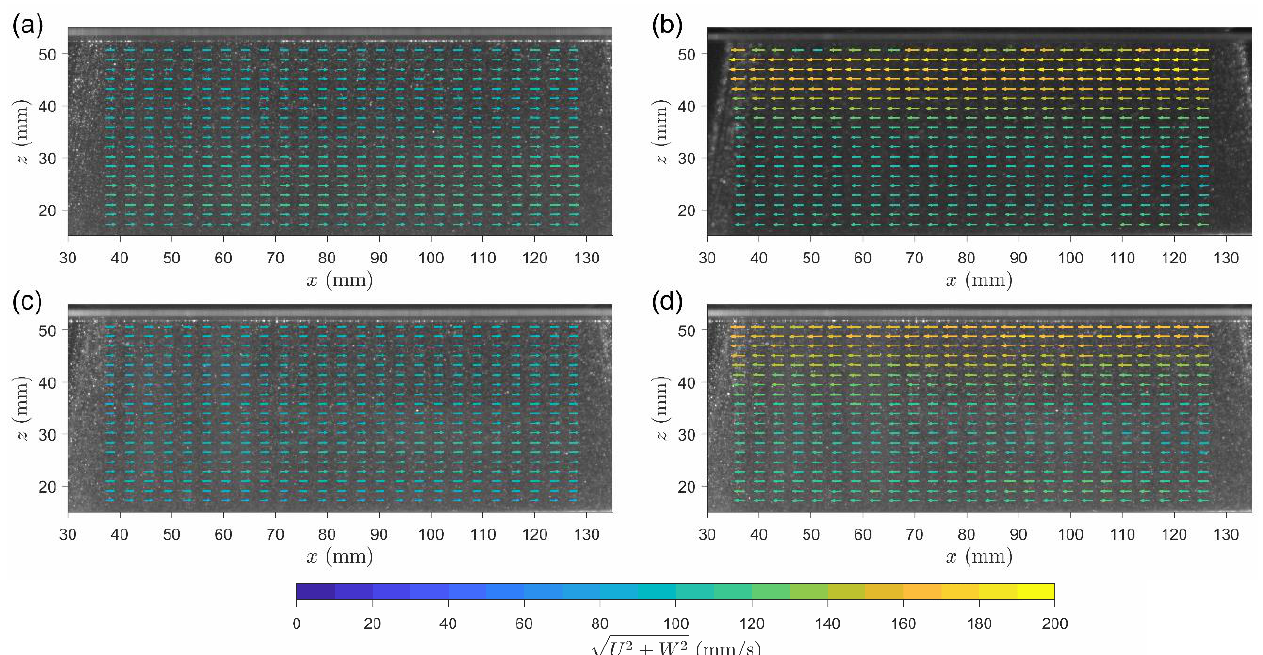
Figure 6. Instantaneous velocity maps determined by typical PIV analysis and the proposed algorithm. ( a ) case PIVR , ( b ) case PIVG , and result corresponding to the ( c ) 1st peak and ( d ) 2nd peak in case PIVB .